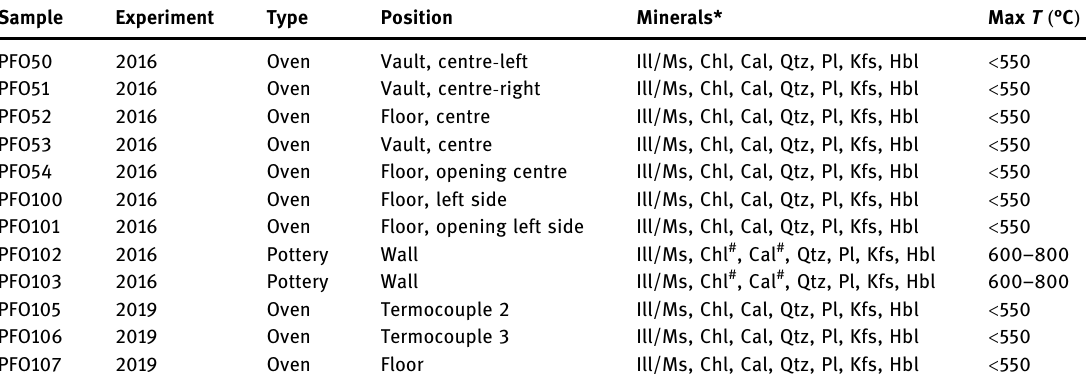
*Mineral abbreviations: Ill/Ms = illite/muscovite; Chl = chlorite; Cal = calcite; Qtz = quartz; Pl = plagioclase; Kfs = K - feldspars; Amph = amphibole; # = thermally